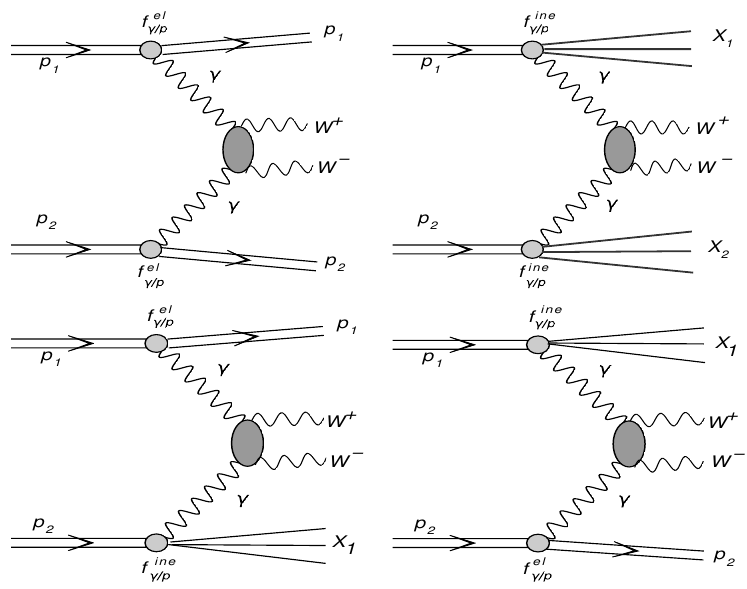
Figure 1 . Diagrams representing di(cid:11)erent categories of photon-photon induced mechanisms for production of W + W (cid:0)